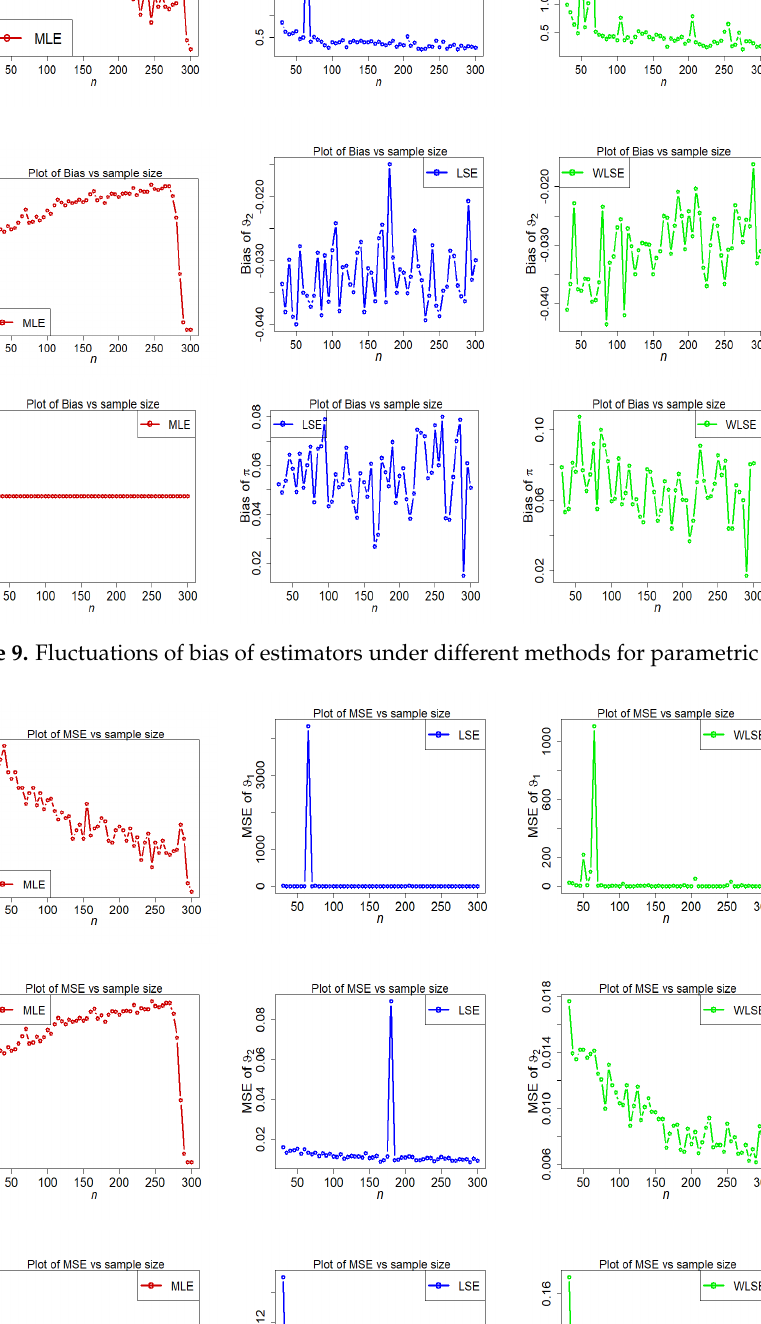
Fig. 10. Fluctuations of MSE of estimators under di⁄erent methods for parametric set II.